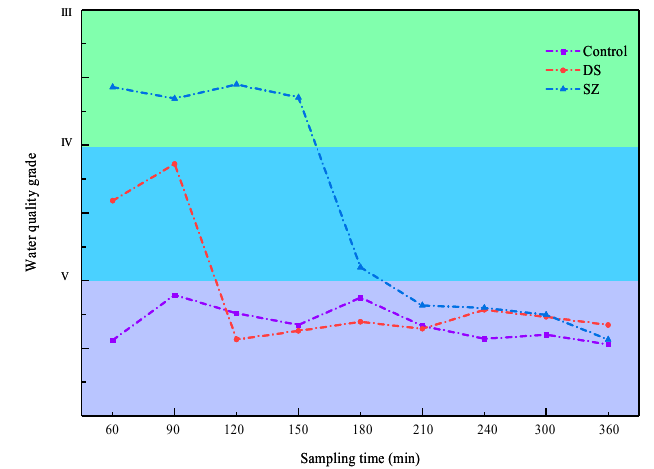
Figure 12. The assessment results of filtered runoff water quality in different bioretention systems.